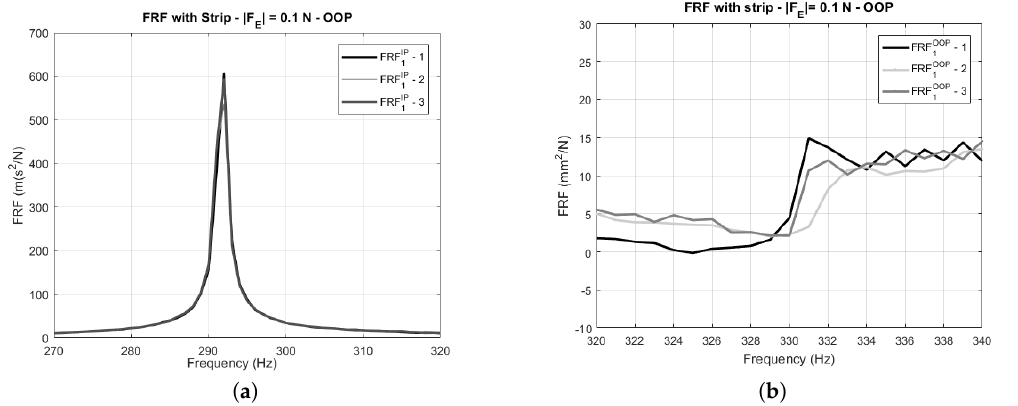
Figure 6. ( a ) IP FRFs of blade 1 for three different tests at F E = 0.1 N; ( b ) OOP FRFs of blade 1 for three different tests at F E = 0.1